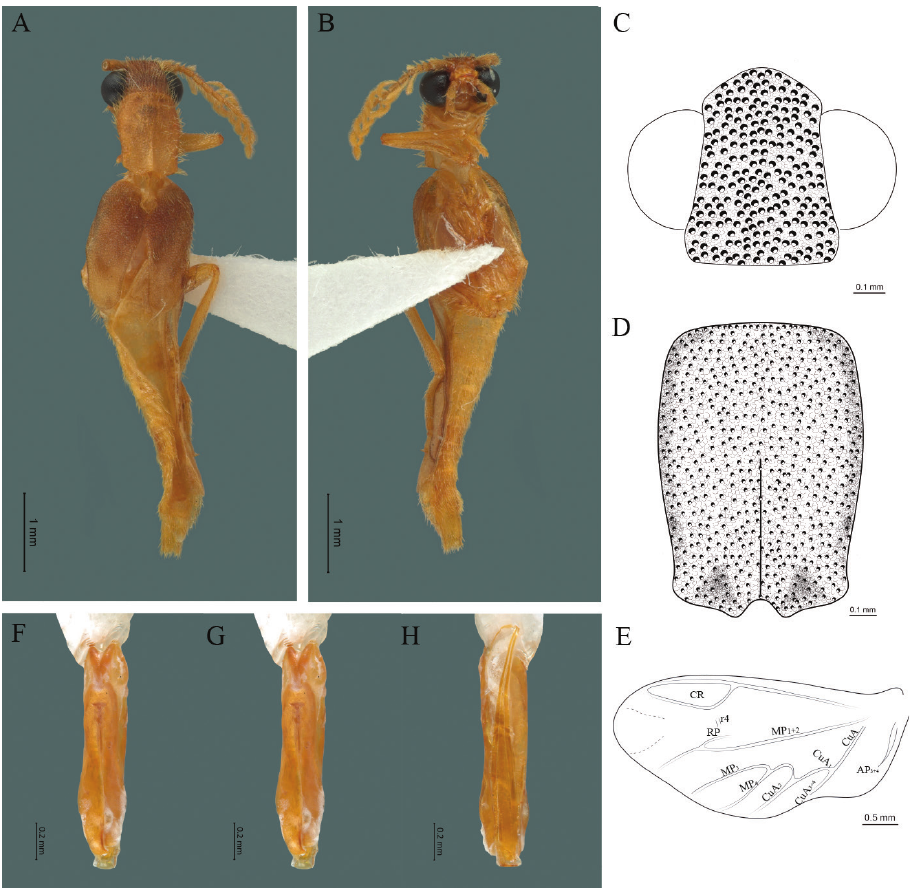
Figure 9. Cenophengus gorhami Zaragoza, 1986, male. Habitus: A dorsal B ventral C head dorsal D pronotum dorsal E hind wing. Wing venation: CR = Radial Cell; r4 = radial 4 vein; RP = Posterior Radial vein; MP1+2 = Posterior Median vein; CuA = Cubital vein; AP = Anterior and Posterior Anal veins. Aedeagus: F dorsal view G lateral view H ventral